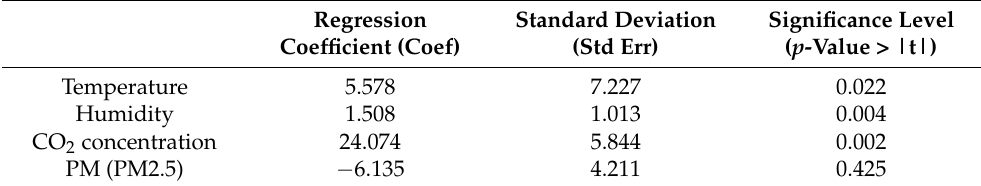
Table 5. Significance test for the algorithm to predict the number of indoor occupants.